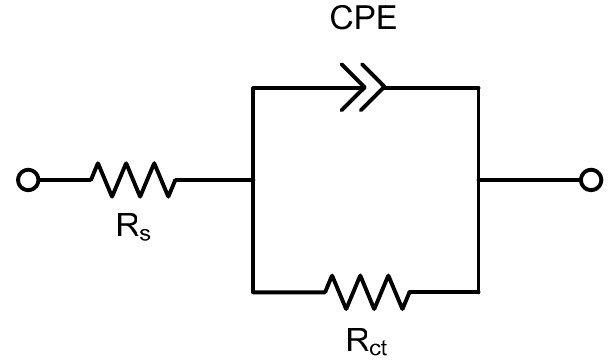
Figure 7. Equivalent circuit for fitting the EIS results for A1070 and U1070 aluminum alloys in a salt water–acetic acid solution at 47 °C.